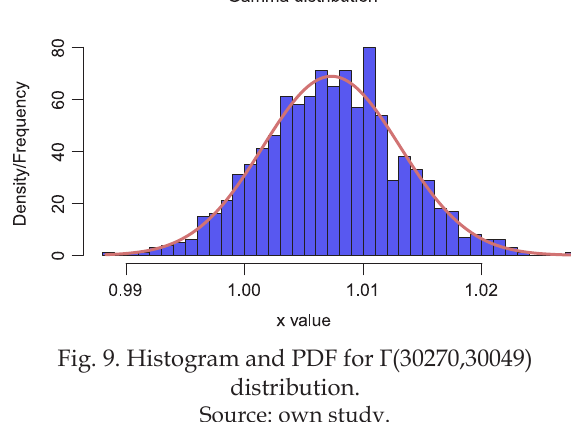
Fig. 9. Histogram and PDF for Γ(30270,30049) distribution.